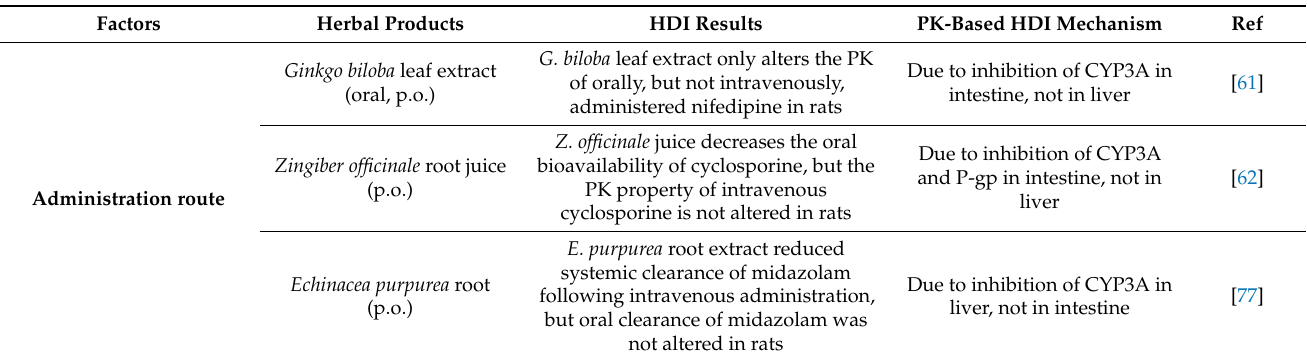
Figure 2. Schematic illustration of the factors that influence herb–drug interactions (HDIs) and the potential outcomes of pharmacokinetic (PK) interactions. The upper three graphs represent plasma concentration-time curve of a drug after oral administration of a drug with and without herbal product: left, co-administered herbal product decreases the plasma concentration of a drug; middle; co-administered herbal product does not affect the plasma concentration of a drug; right; co-administered herbal product increases the plasma concentration of a drug. Also the lower three graphs represent plasma concentration-time curve of a drug after intravenous administration of a drug with and without herbal product: left, co-administered herbal product increases the plasma concentration of a drug; middle; co-administered herbal product does not affect the plasma concentration of a drug; right; co-administered herbal product decreases the plasma concentration of a drug. In all cases, a herbal product is orally administered. D and H indicates a drug and a herbal product, respectively. Table 1. Factors causing conflicting HDI